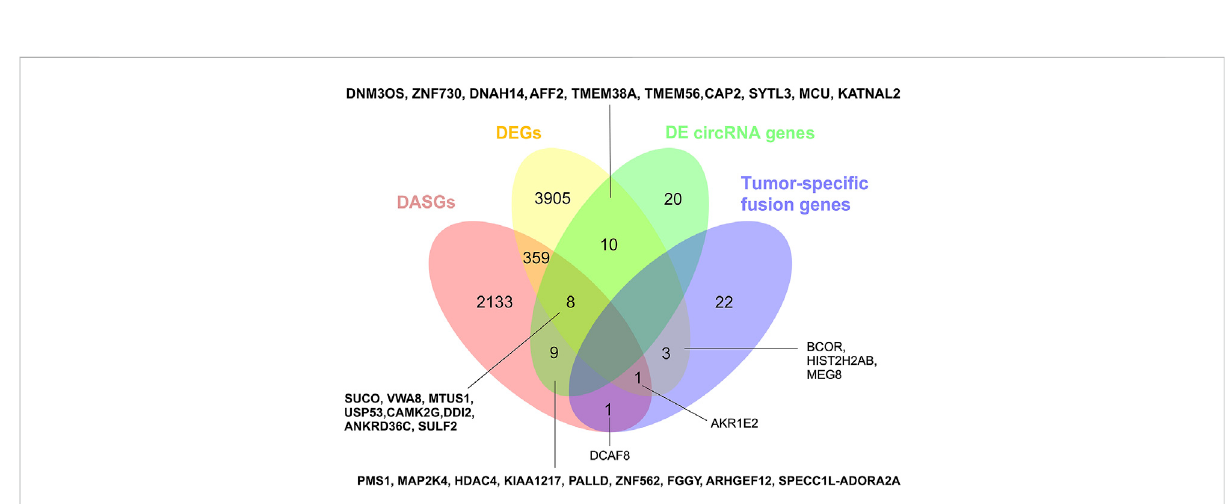
FIGURE 5 Comparison of DEGs, DASGs, fusion genes, and the parental genes of differentially expressed circRNAs. The overlapped genes for each part were shown in the fi gure. DEGs: differentially expressed genes; DASGs: differentially alternative spliced genes.